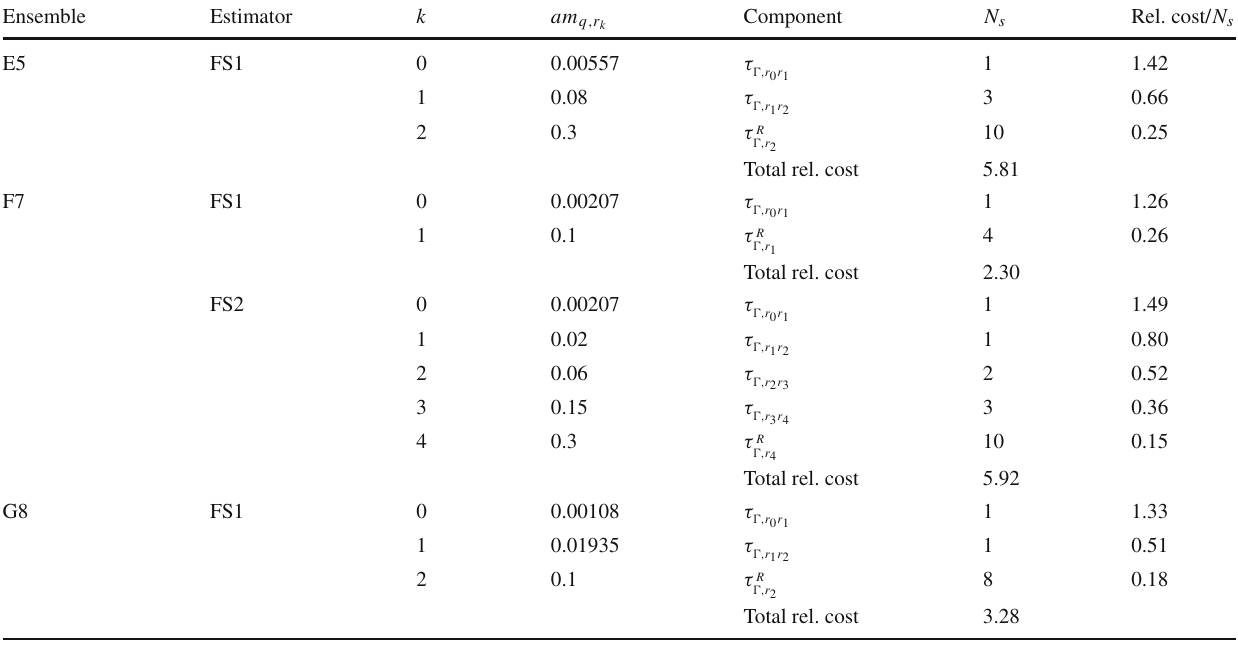
Table2 ThetotalcostofoneevaluationoftheFSestimatornormalized is given with the number of times it is evaluated for each full evaluation to the cost of one evaluation of the standard estimator, for examples of of the FS estimator, along with the bare subtracted quark masses which the FS estimators on all ensembles. The cost of the split-even compo- define the estimator. Note that the overhead required to compute the nents, τ (cid:6), exact hopping terms is not included, which is performed only once , is defined as the time for the two required inversions rkrk + 1 per source, while the cost of the remainder, τ R , is the single inversion (cid:6), rm requiredpersource.Thestandardestimatorrequiresoneinversionatthe sea-quark mass m q , r per source. The relative cost of each component 0